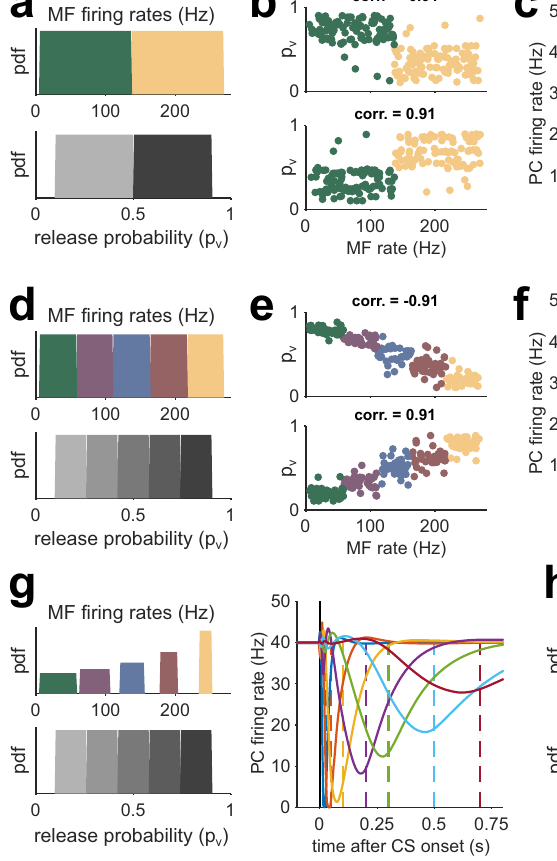
Fig. 5 | Correlating release probability and MF fi ring rates improves learning performance. a Top: distribution of MF fi ring rates ( m ) usedto drive the network, divided into low (supporter, green) and high (driver, yellow) rates. Bottom: Dis- tributionofsynapticreleaseprobabilities( p v ),dividedintolow(lightgray)andhigh (darkgray)probabilities. b Top: p v versusmfor500samplesynapsesforanetwork with a strong negative rank correlation between the m category (supporter or driver) and the p v category (high or low). Bottom: same as top, but for strongly positive correlated m and p v . c Learned PC pauses for low (left) and high (right) correlations.CS-USintervalsarecolor-coded asinFig.2f.Eachcurveisthe average